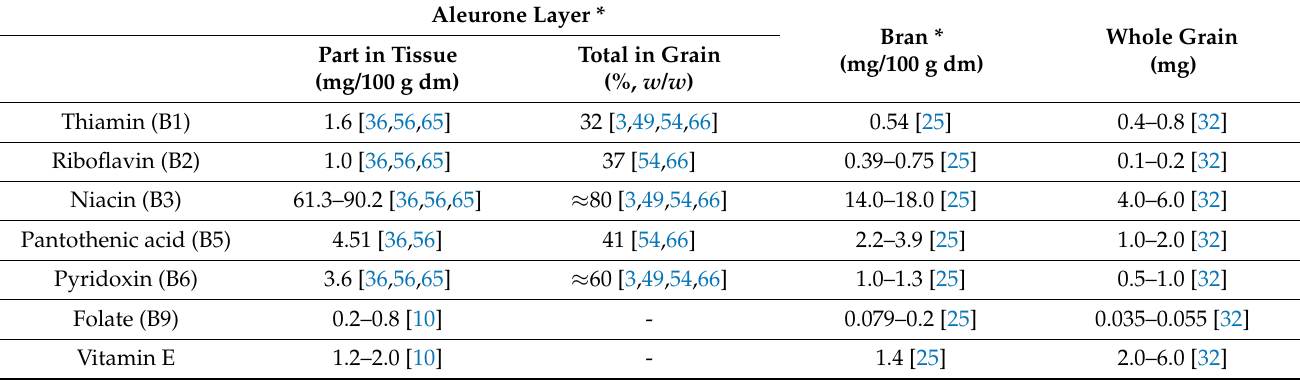
Table 5. Vitamins repartition in the wheat aleurone layer, bran and whole grain.